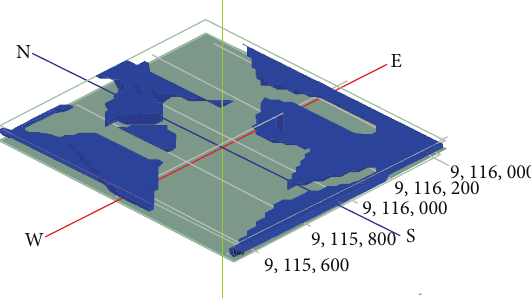
Figure 14: The underground seepage of hot water in Blawan geo- thermal